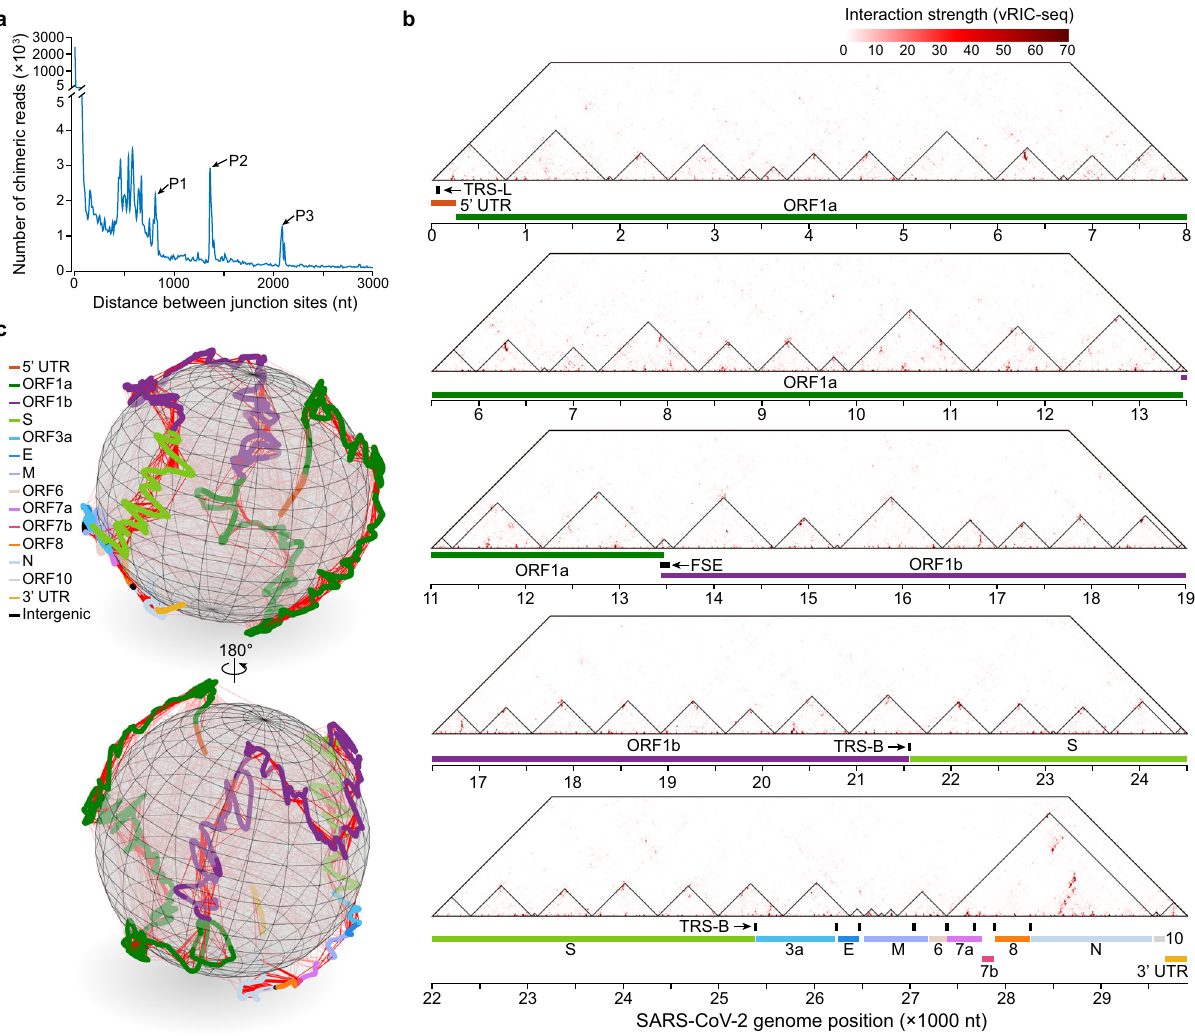
Fig. 2 Global view of SARS-CoV-2 genome organization. a Spanning distance of pairwise interacting RNAs. P1, P2, and P3 mark three peaks corresponding to chimeric interactions spanning 810, 1360, and 2090 nucleotides. b RNA interaction map of the SARS-CoV-2 genome. The black triangles represent RNA topological domains. The frame-shifting element (FSE), the transcription-regulatory sequence in the leader (TRS-L), and the body (TRS-B) are marked as black lines. c The global con fi guration of the SARS-CoV-2 RNA genome in virions, modeled by the miniMDS software. The 30 kb RNA genome of SARS- CoV-2 is presented as a rope, and each coding region and UTR are marked with different colors. The vRIC-seq detected RNA contact frequencies were used for the modeling. The solid red lines represent chimeric signals that support the local interactions, whereas the dashed red lines depict long-range interactions. The same picture rotated in 180 degrees is shown at the